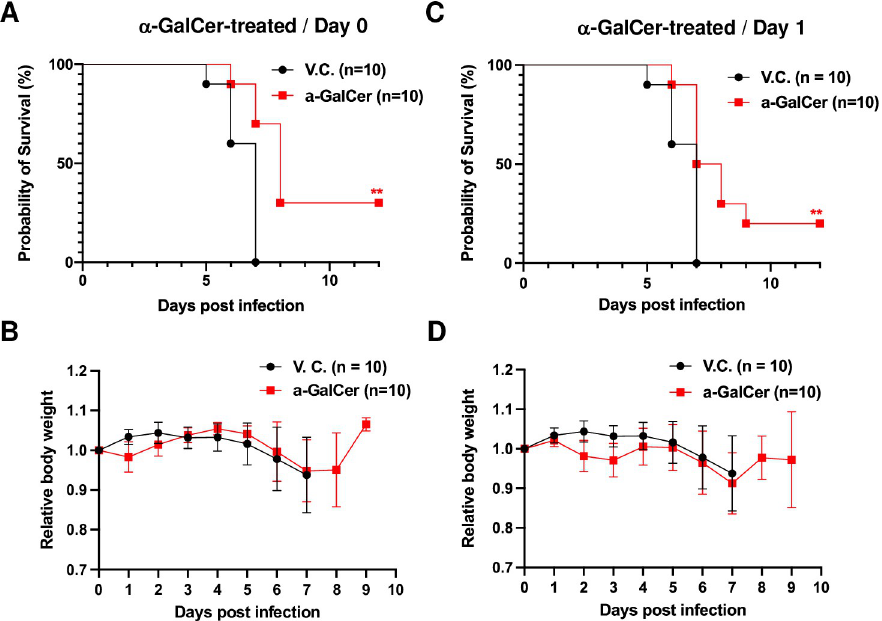
Fig 9. Therapeutic activation of iNKT cells post SARS-CoV-2 infection can mitigate disease severity and improve host survival in mice. K18-hACE2-Tg mice (n = 10 per group) were infected with SARS-CoV-2 (Isolate USA-WA1/ 2020, 1X10e4 pfu per mouse) then immediately administered with α -GalCer (2 μ g per mouse) (A, B) or administered once with α -GalCer (2 μ g per mouse) at one day post infection (C, D). Representative data of three independent experiments were presented. Infected mice were monitored daily for body weight and disease severity. Differences in animal survival were evaluated with Mantel–Cox log-rank test. ** p < 0.01.